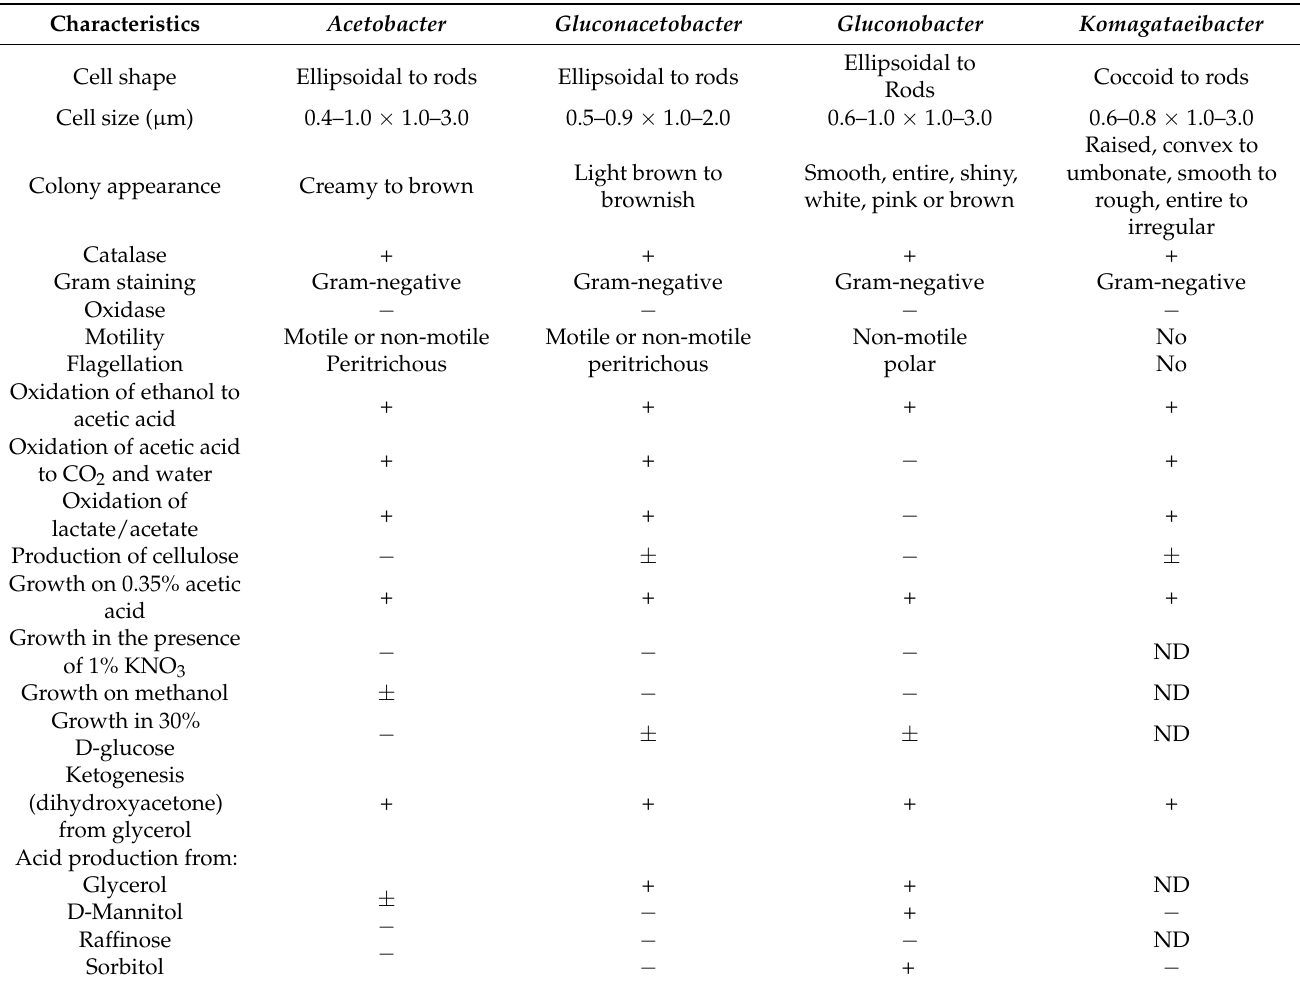
Table 5. Differential characteristics of the genera Acetobacter , Gluconacetobacter , Gluconobacter and Komagataeibacter commonly associated with